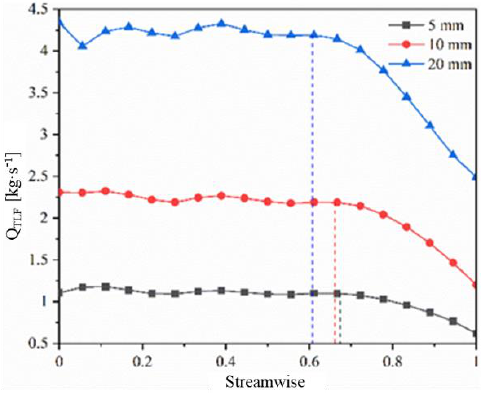
Figure 8. Leakage flow.